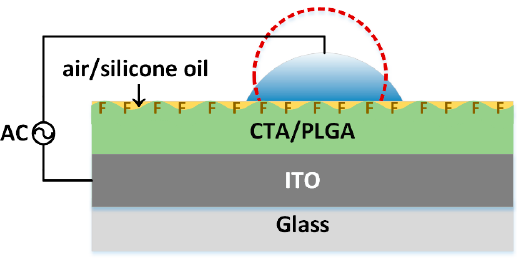
Figure 1. Schematics of CA measurement with the filler medium of air or silicone oil.